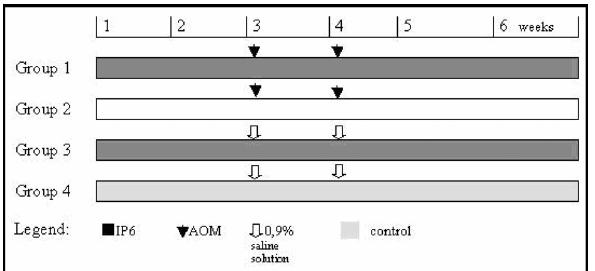
FIGURE 1 - Protocol for the administration of